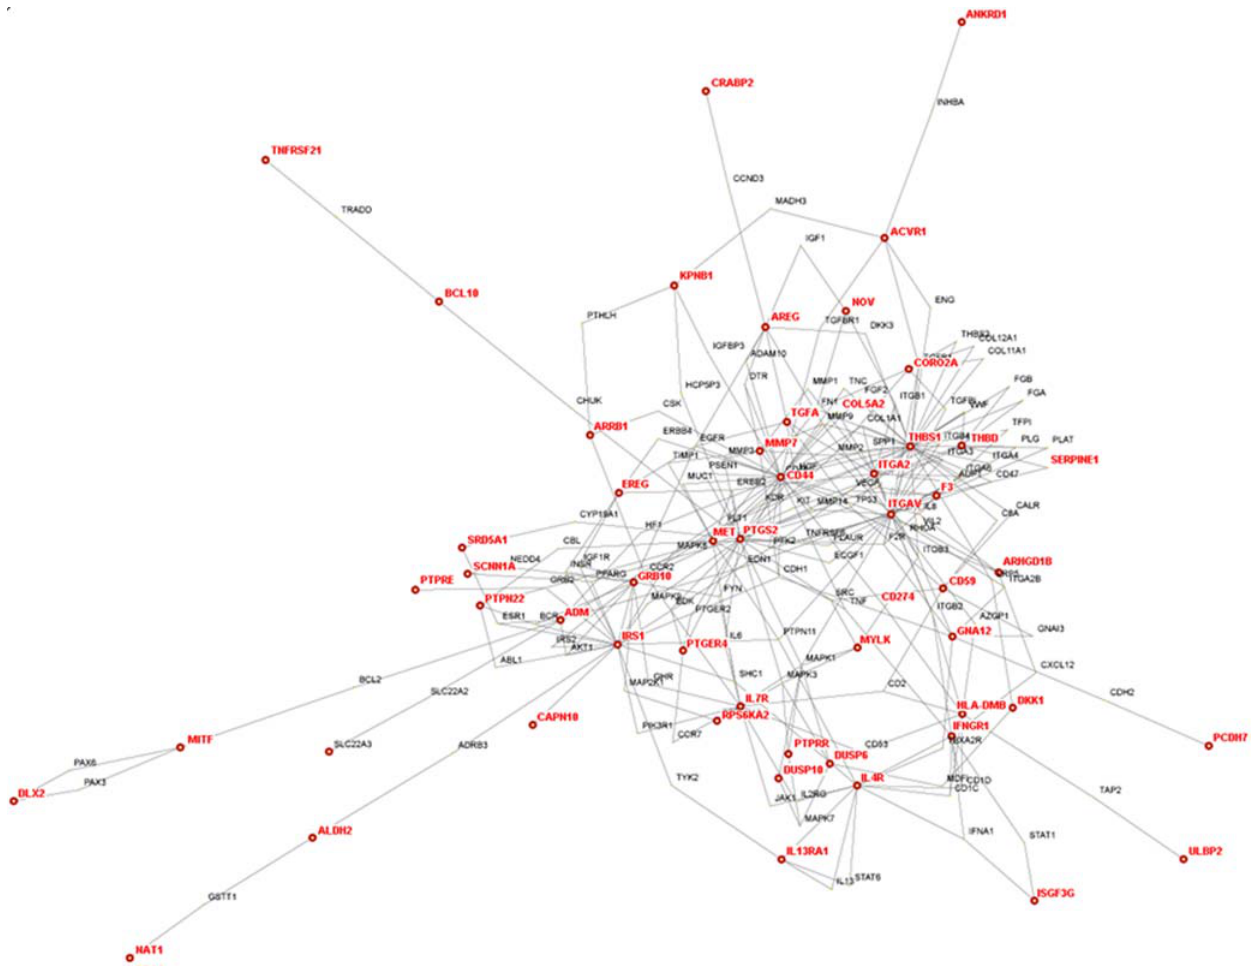
Figure 3. Interactome of genes in the mutant EGFR expression signature. Theoretical protein-protein physical and functional interaction map (interactome) was drawn using HiMAP software. Genes from the signature are indicated in